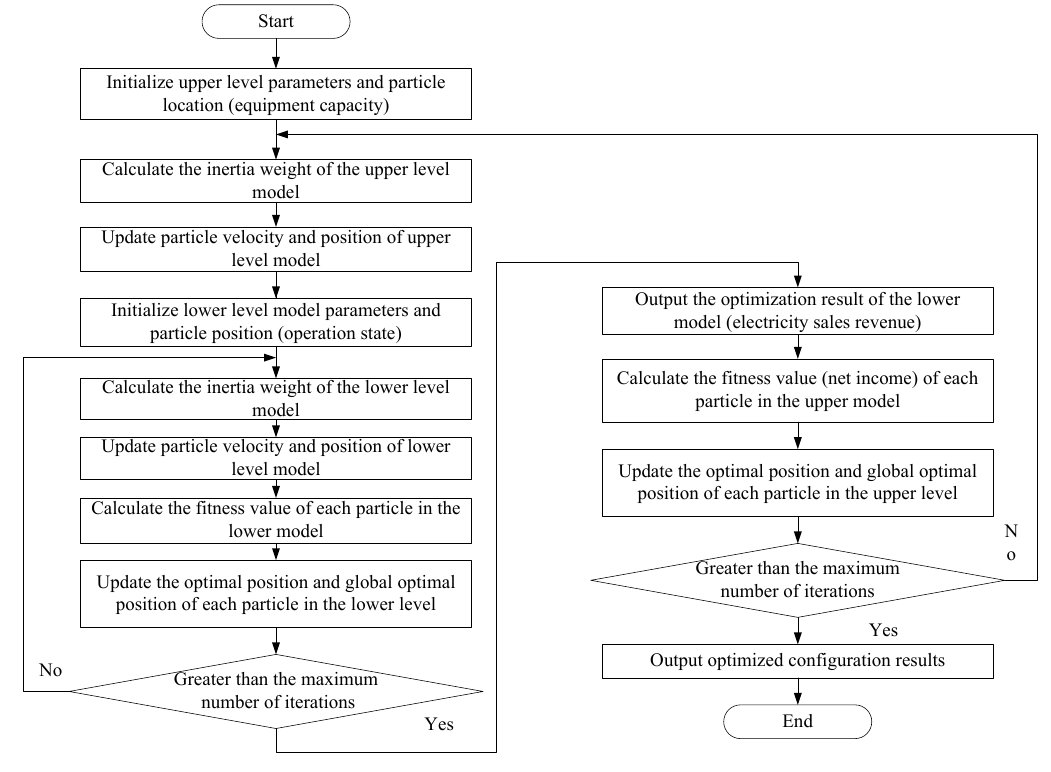
Figure 3. Model solution flowchart.